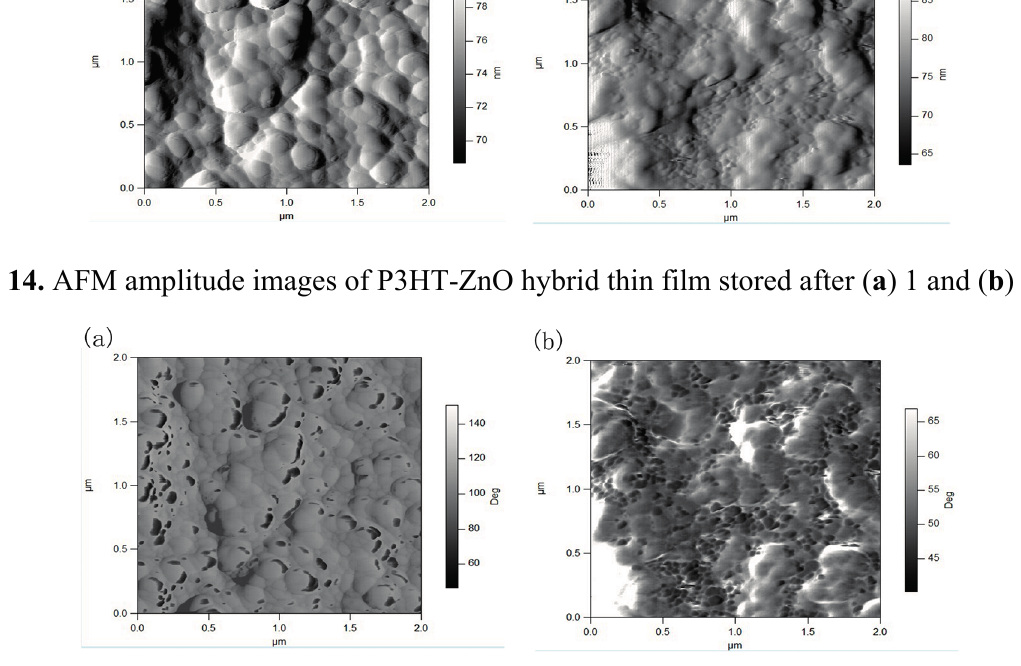
Figure 15. AFM phase images of P3HT-ZnO hybrid thin film stored after ( a ) 1 and ( b ) 15